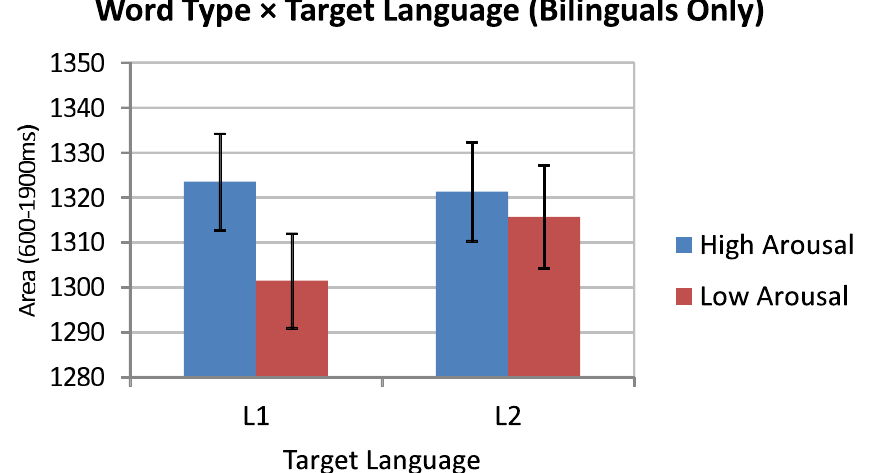
Fig 4. Estimated marginal means (with 95% CIs) for the Target Language × Word Type Interaction. (Analysis considering bilingual participants only). Dependent variable was the pupil size area under the curve from 600-1900ms after stimulus onset. Means and CIs are covariate-adjusted.